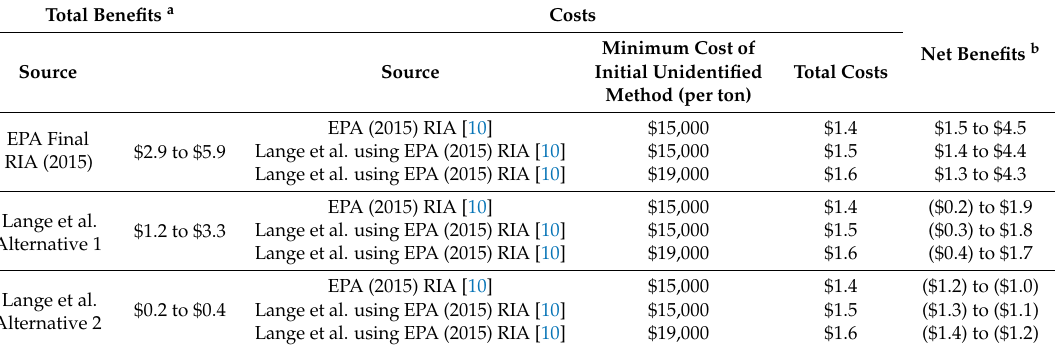
Table 7. Estimate of Monetized Ozone and PM 2.5 Net Benefits for Annual Ozone Standard of 0.070 ppm 2025 Scenario, using EPA (2015) [10] as the basis (nationwide benefits of attaining each alternative standard everywhere in the U.S. except California and except as noted)—Full Attainment (billions of 2011$) a